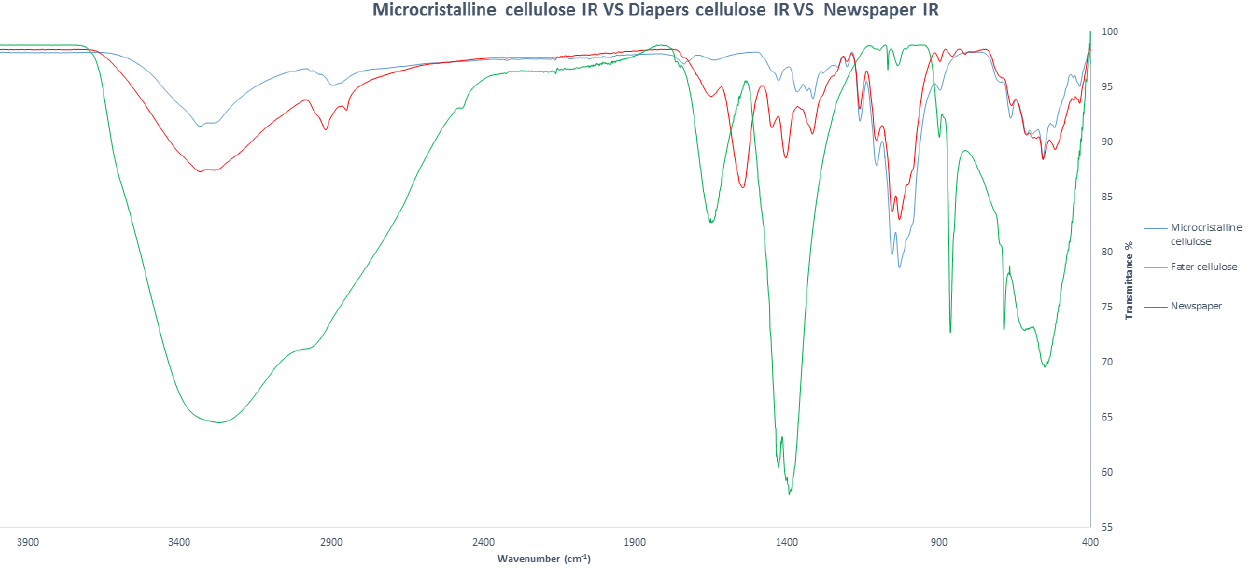
Figure 2. Comparison of FTIR-ATR spectra between the commercial microcrystalline cellulose (blue line) with diaper cellulose (red line) and newspaper cellulose (green line).